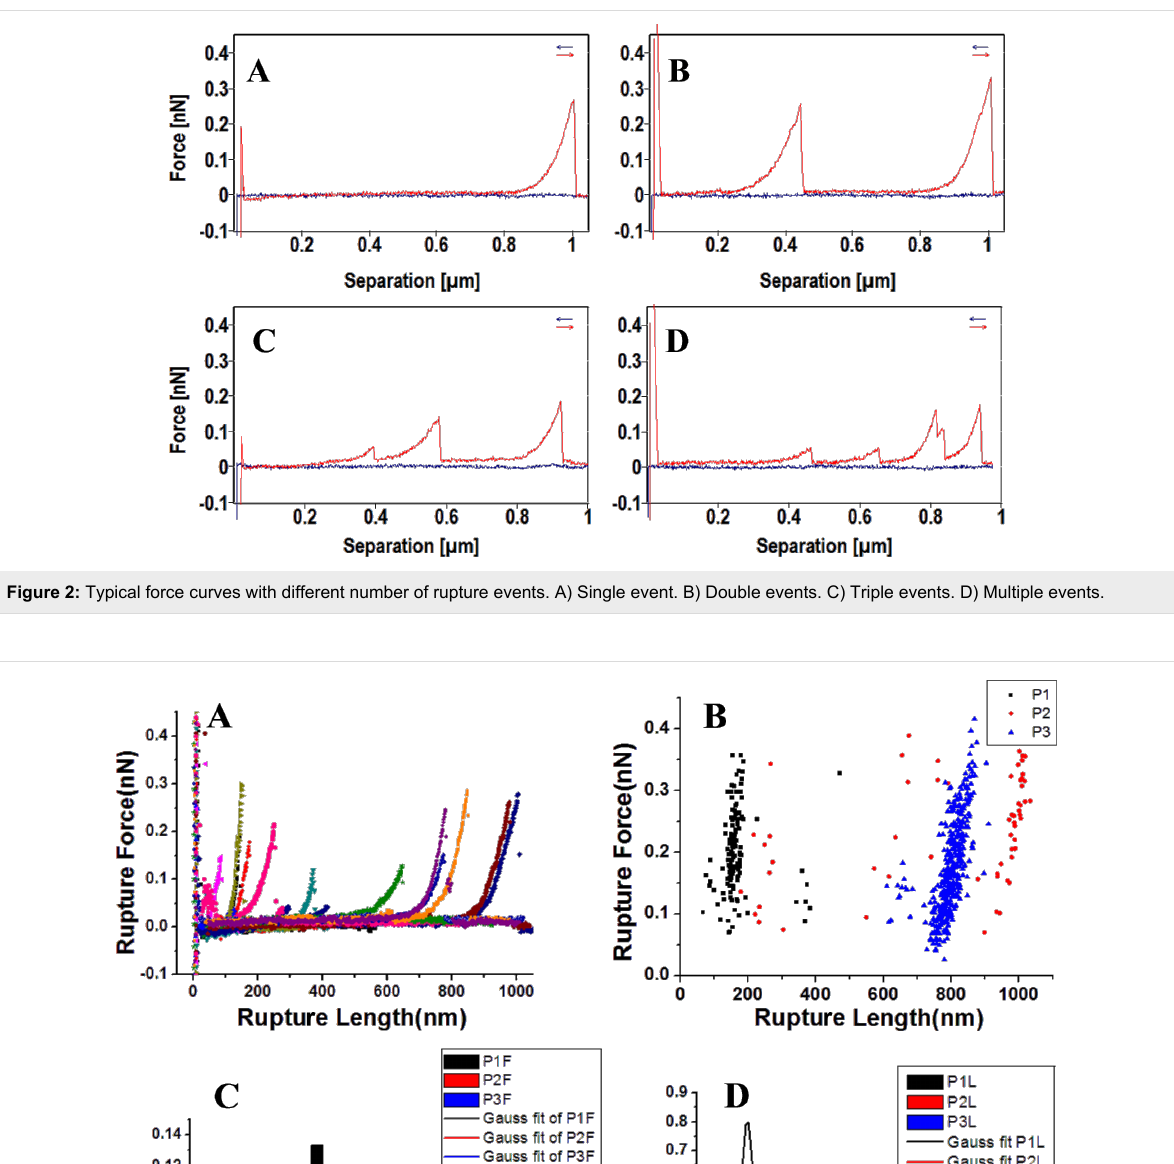
ranging from 750 to 900 nm. The huge difference of rupture length can be attributed to the different length of free xanthan fibrils between the junctions in the fibril network. At P 1 , xanthan fibrils intensely wind and overlap with each other,